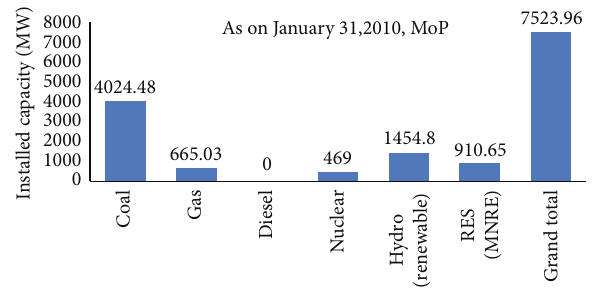
Figure 1: Installed capacity of power utilities in